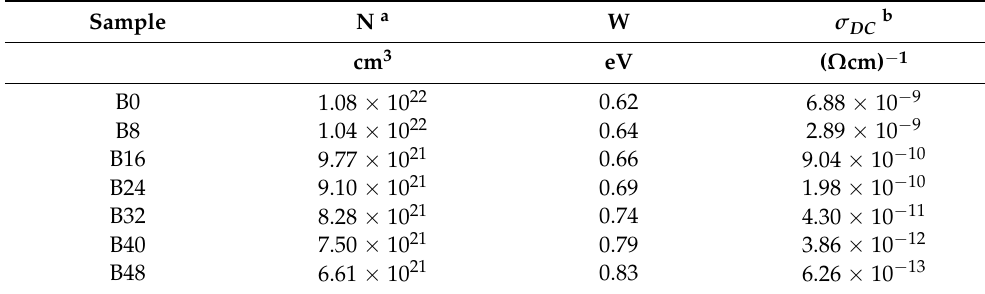
Table 3. The number density of sodium ions, N, DC conductivity, σ DC , determined as a plateau value in the conductivity isotherms, activation energy, W DC , for (100 − x)[0.4Na 2 O-0.2Nb 2 O 5 -0.4P 2 O 5 ]- xB 2 O 3 , 0 ≤ x ≤ 48 mol%,